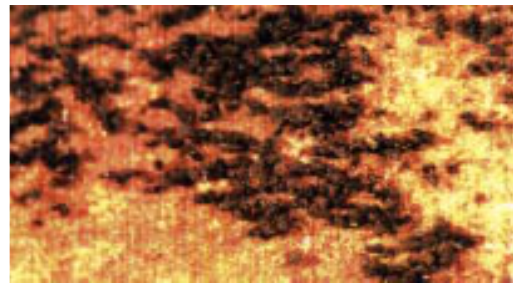
Fig. 5. Phaeoacremonium chlamydosporum – longitudi- nal section of pycnidium produced on moist incubated wood. (VPRI 22081b).